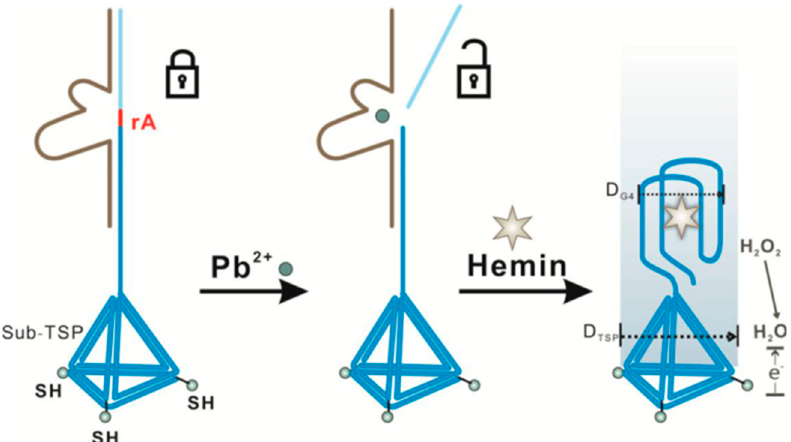
Figure 10. Label-free biosensor for voltammetric determination of Pb 2+ based on the Pb-DNAzyme triggered G-quadruplex/hemin on a TSP-modified AuE. Reprinted from [54] with permission.